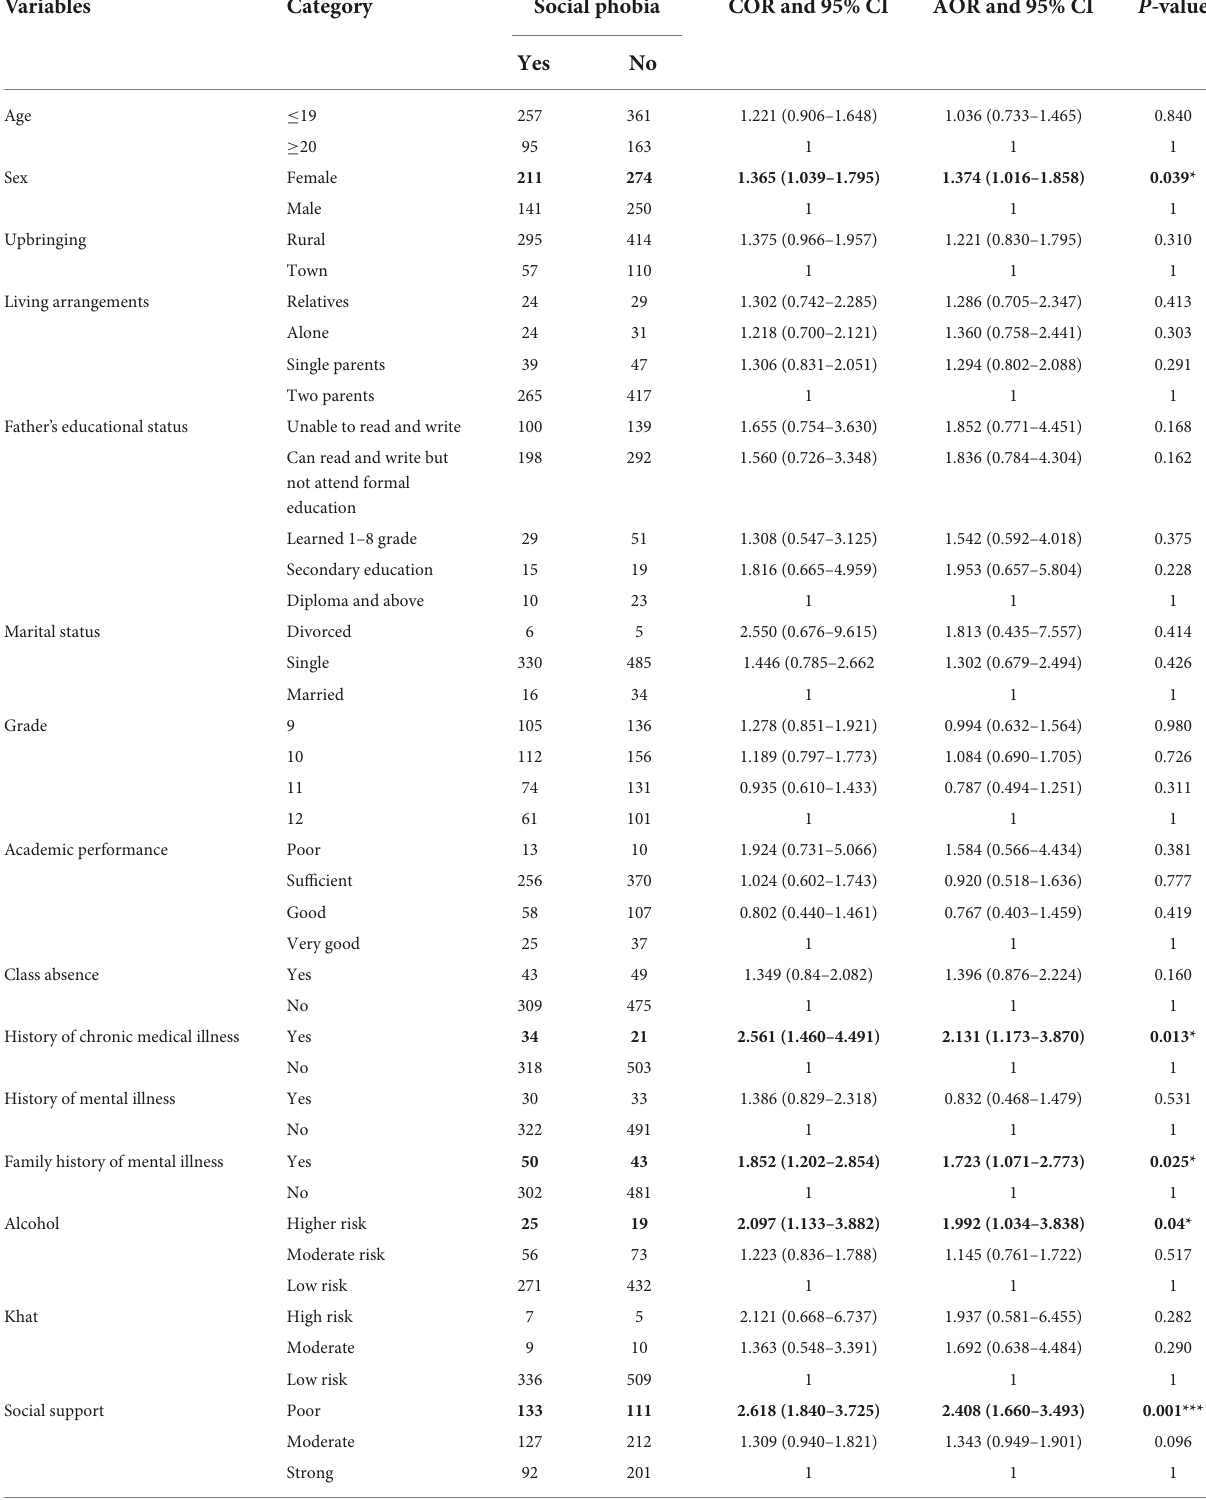
TABLE 4 Bivariate and multivariate analyses of factors associated with social phobia (SP) among high school adolescents in Northwest Ethiopia ( n = 876), 2021 Gorgonian Calendar (GC).